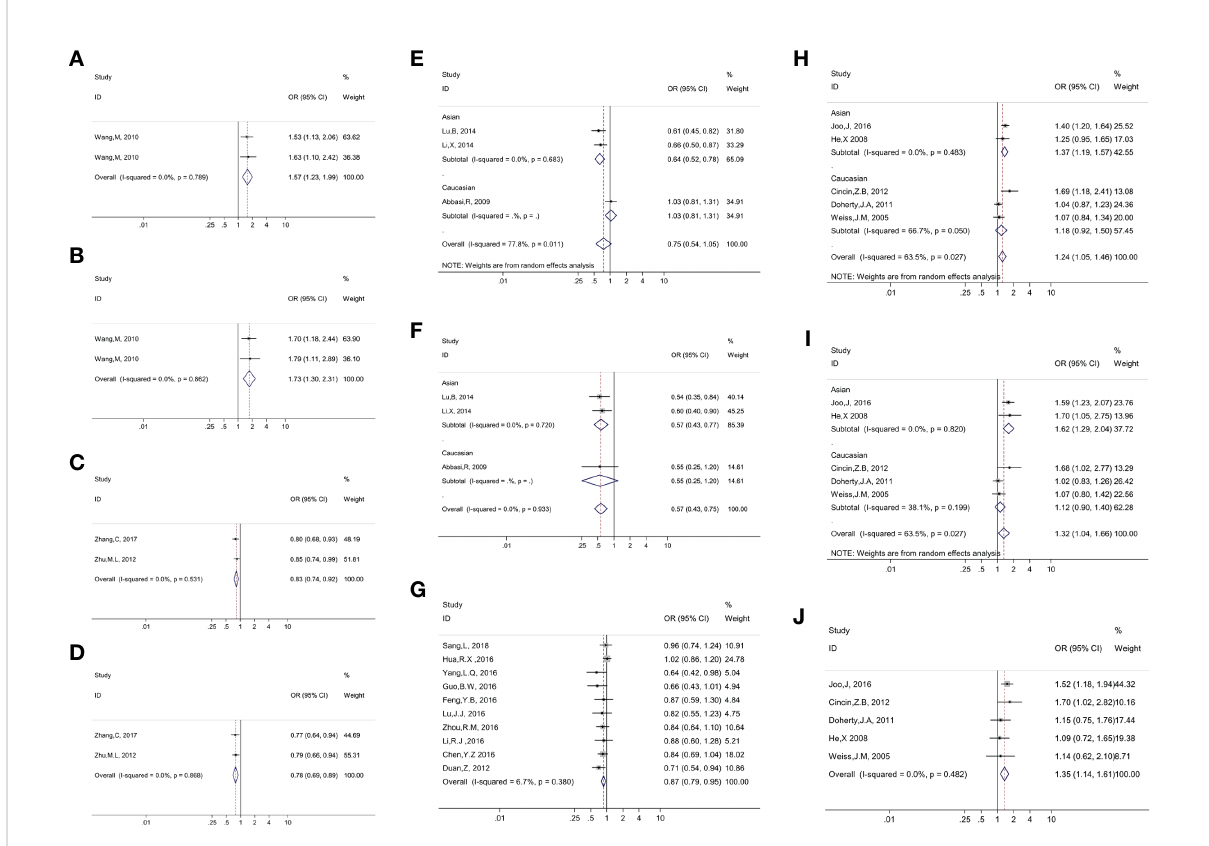
FIGURE 2 Presented forest plot of 10 strong-credibility evidence: (A). association between ERCC4 rs744154 and bladder cancer risk in the Asian population in the allelic model; (B). association between ERCC4 rs744154 and bladder cancer risk in the Asian population in the recessive model; (C). association between ERCC5 rs2296147 and esophageal cancer risk in the Asian population in the allelic model; (D). association between ERCC5 rs2296147 and esophageal cancer risk in the Asian population in the dominant model; (E). association between ERCC5 rs17655 and laryngeal cancer risk in the allelic model, strati fi ed by ethnicity; (F). association between ERCC5 rs17655 and laryngeal cancer risk in the recessive model, strati fi ed by ethnicity; (G). association between ERCC5 rs751402 and gastric cancer risk in Asian population in the recessive model; (H). association between ERCC5 rs17655 and Uterine cancer risk in the allelic model, strati fi ed by ethnicity; (I). association between ERCC5 rs17655 and uterine cancer risk in the dominant model, strati fi ed by ethnicity; (J). association between ERCC5 rs17655 and uterine cancer risk in overall population in the recessive